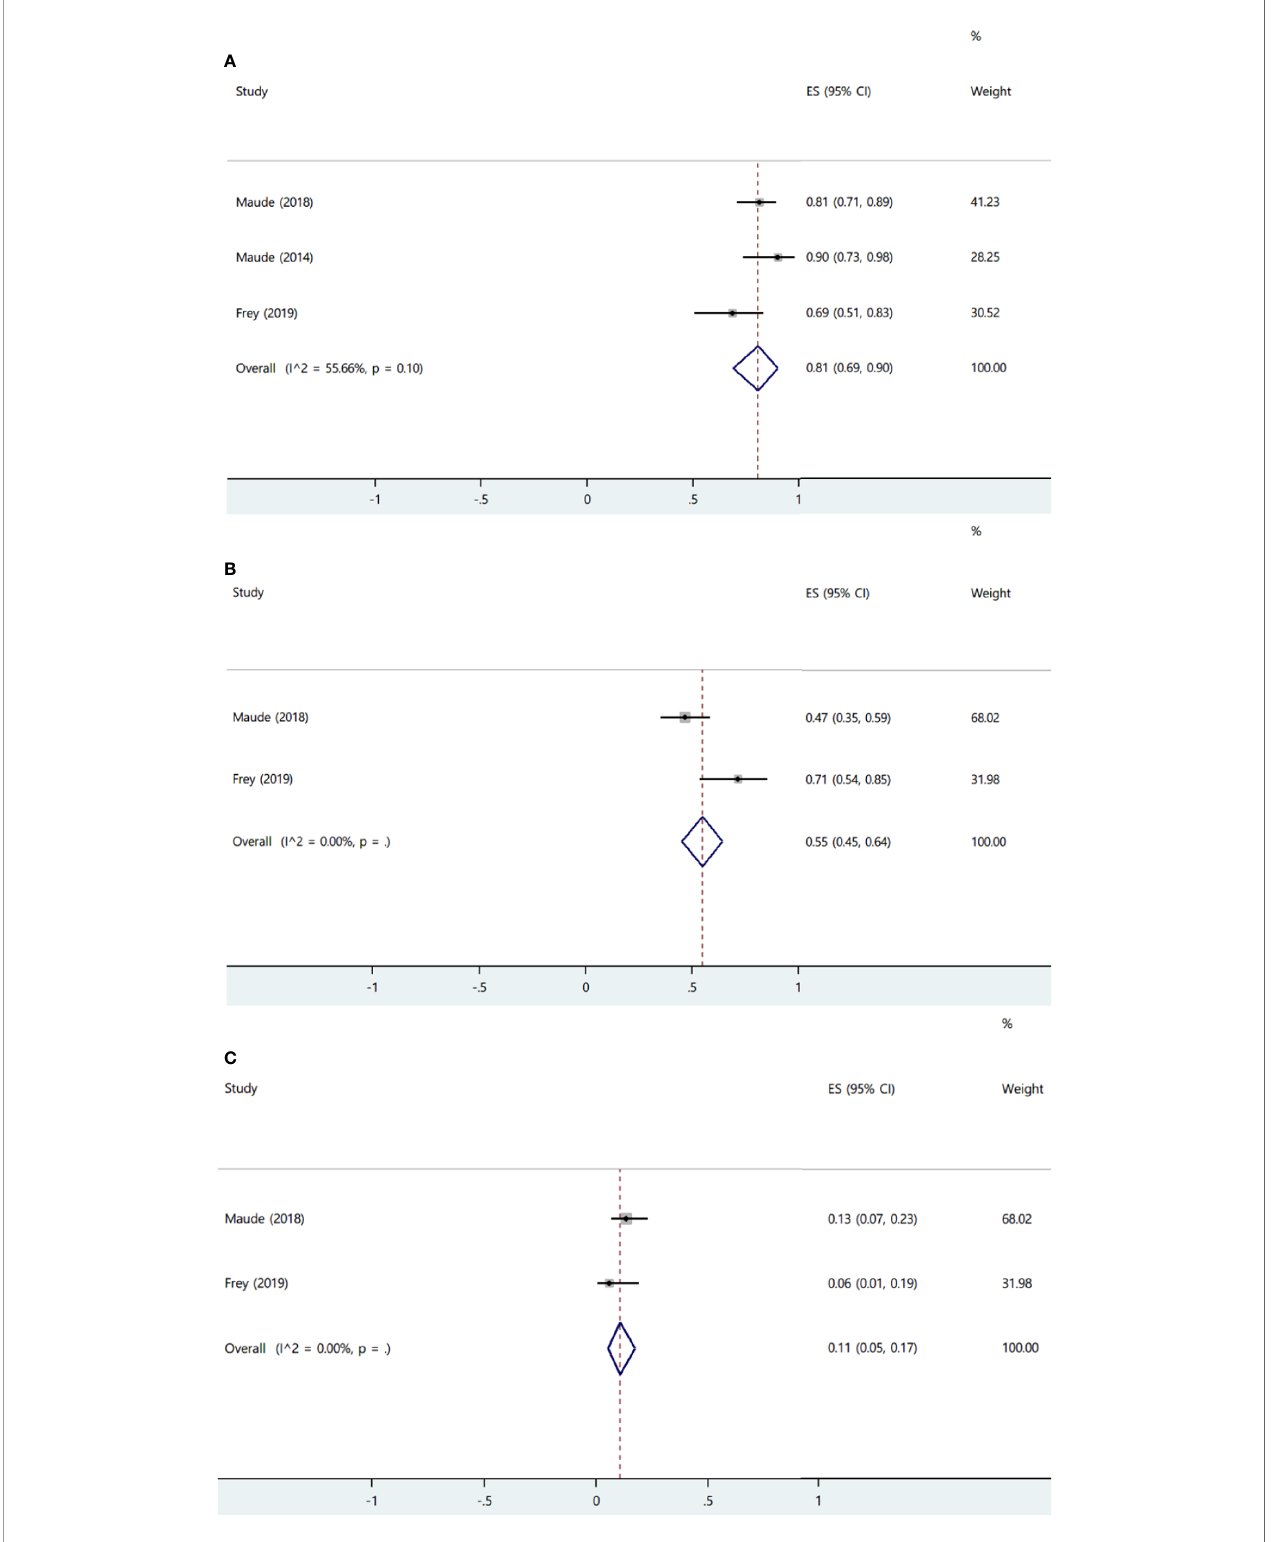
FIGURE 8 | The forest plots of pooled results in patients with acute lymphoblastic leukemia. (A) The forest plot of complete response rate of tisa-cel. (B) The forest plot of severe cytokine release syndrome rate of tisa-cel. (C) The forest plot of severe immune effector cell-associated neurotoxicity syndrome rate of tisa-cel.